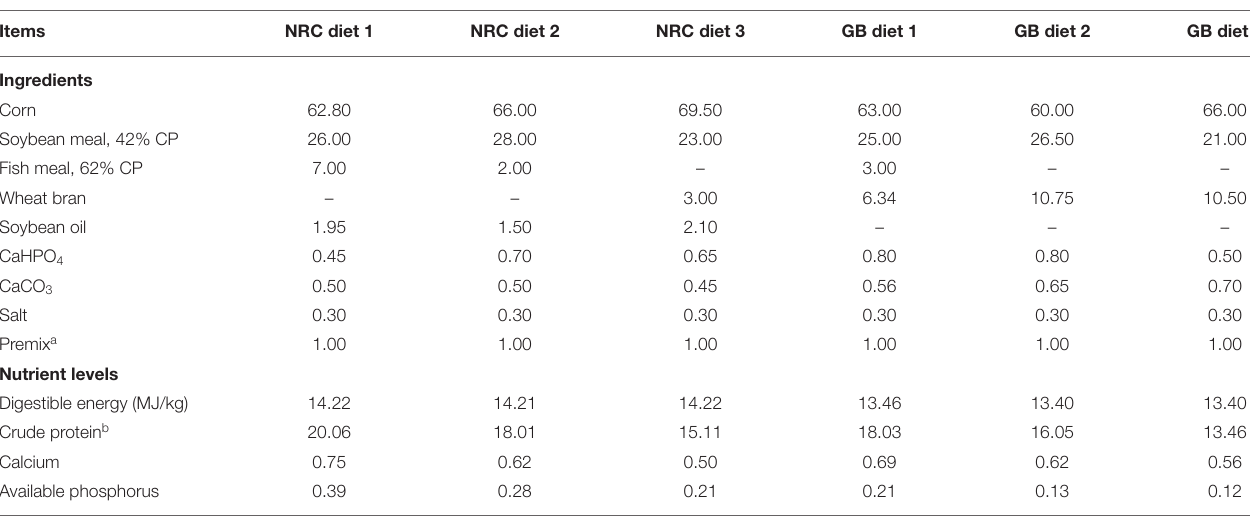
TABLE 2 | Ingredients and nutrient levels of experimental diets